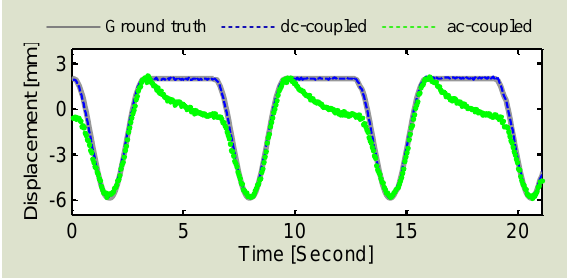
Figure 10. Experimental results of using both DC radar and AC radar to measure the actuator motion which is sinusoidal with a stationary moment in between two cycles.